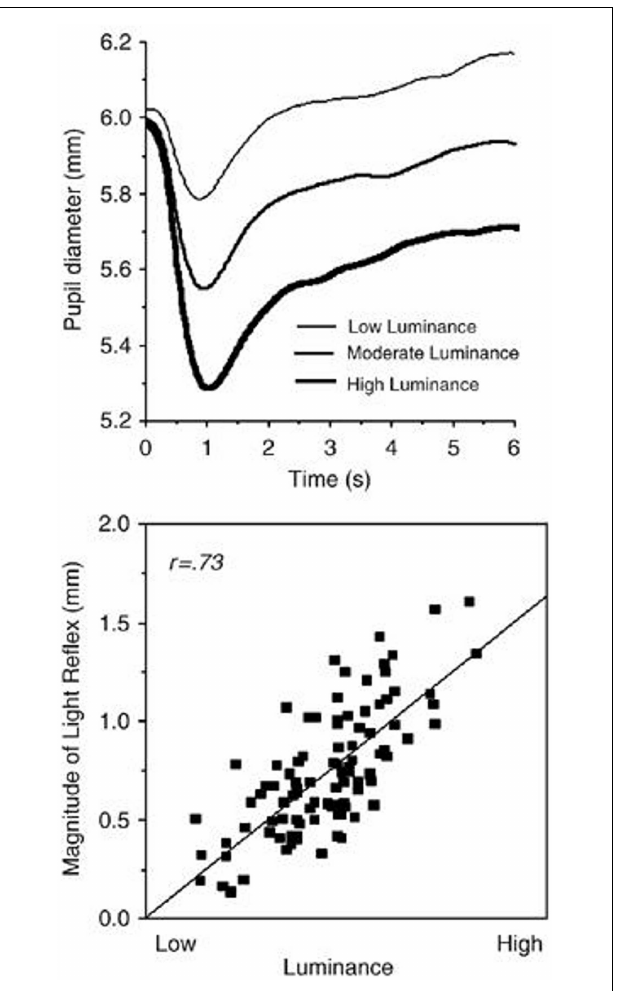
FIGURE 3 | (Top)Average pupil diameter over time as a function of luminance of the image viewed .This variation is termed the light reflex. (Bottom) correlation of the magnitude of the light reflex as a function of image luminance (Taken from Bradley et al., 2008). females portraits ( M = 5.3) [ t (1, 78) = 3.07, p = 0.003, d = 0.69].